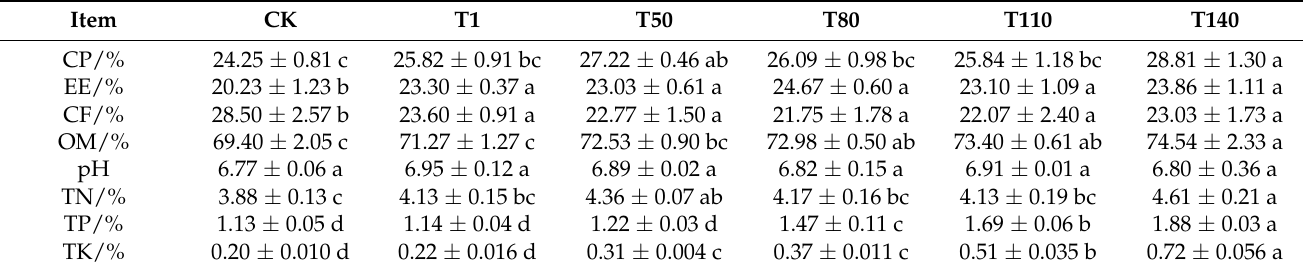
Table 5. Effect of adding DKW on the content of nutrients in